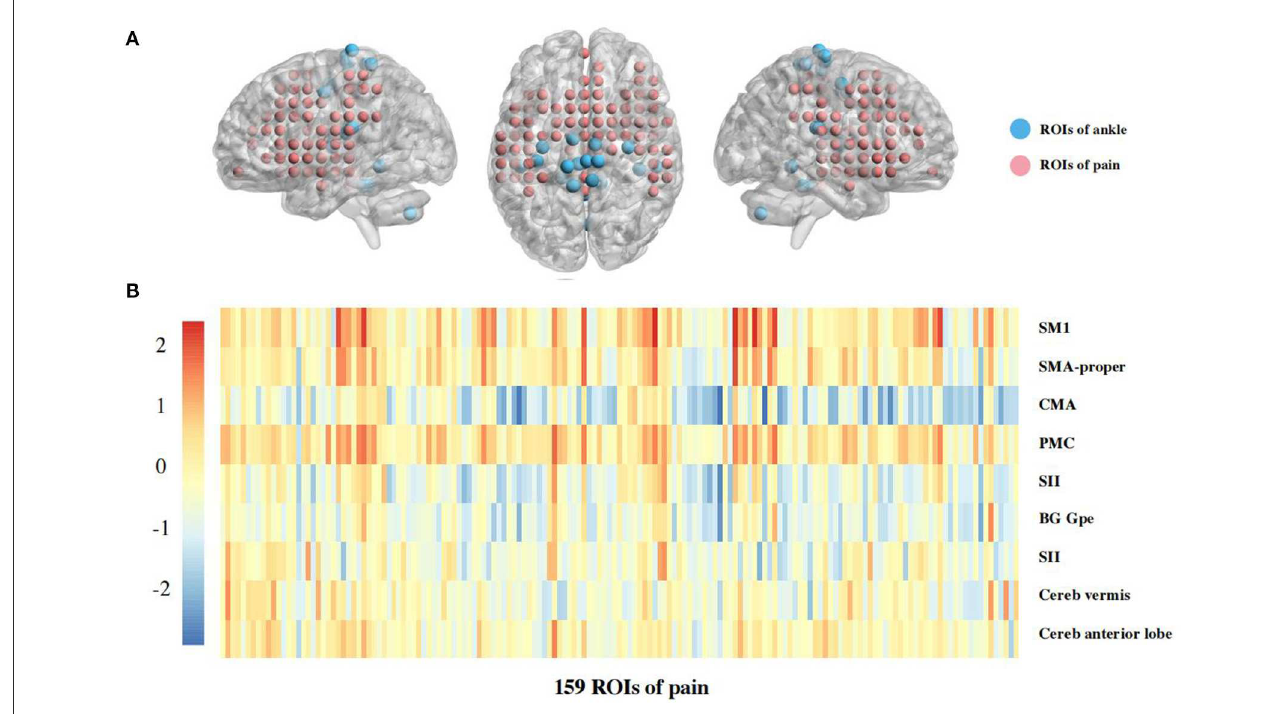
FIGURE2 (A) The ROIs in global brain as sphere. Each ROI was put in a brain as sphere, for blue color was ROIs of ankle motor regions, and for red color was ROIs of pain regions. (B) Heatmaps of functional connectivity between 9 ROIs of ankle activity and 159 ROIs of pain in the global brain. Warmer colors (red and yellow regions) indicate stronger connectivities whereas cooler colors (blue and green regions) indicate weaker connectivity. The 9 ROIs associated with ankle activity are primary sensorimotor cortex (SM1); supplementary motor area (SMA-proper); cingulate motor area (CMA); premotor cortex (PMC); secondary sensory cortex (SII); basal ganglia (BG); external segment of globus pallidus (Gpe); cerebellum (Cereb), in which signsificant differences presented between CMA and Insula ( p = 0.005), CMA and Putamen ( p = 0.004), CMA and Rolandic Operculum ( p = 0.004), SII and Putamen ( p = 0.009). These ROIs were validated in part 2 of this study.